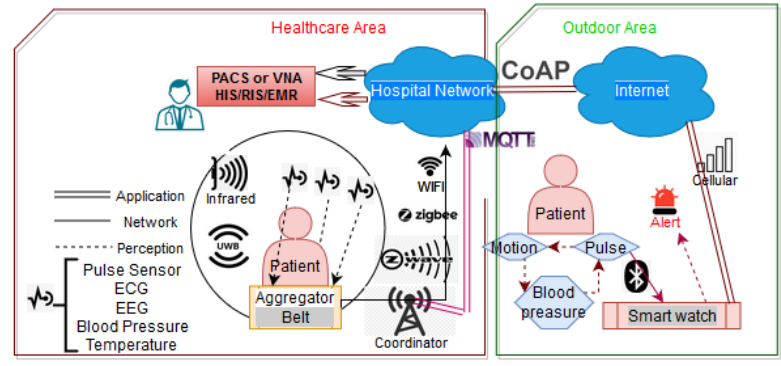
Figure 2. Communication among wearable sensors.